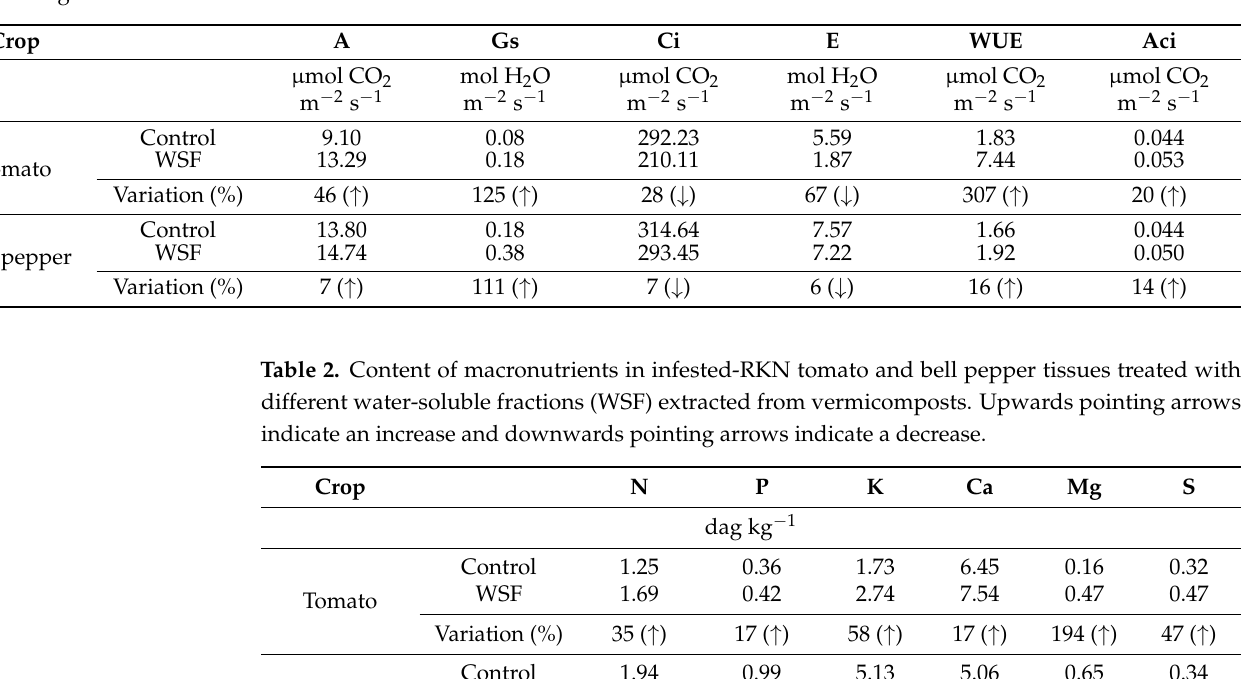
Table 1. Photosynthetic rate (A), stomatal conductance (gs), Internal CO 2 concentration (Ci), transpiration rate (E), water use efficiency (WUE) and carboxylation capacity (Aci) in infested-RKN tomato and bell pepper plants treated with different water-soluble fractions (WSF) extracted from vermicomposts. Upwards pointing arrows indicate an increase and downwards pointing arrows indicate a decrease.